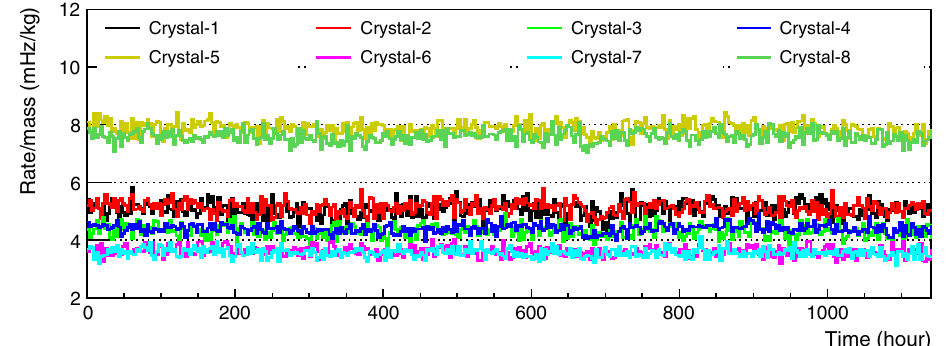
Fig. 15 Crystal trigger rates versus time (in h) for the first physics run (48 days). All of the crystals show stable behavior throughout this running period and the rest of data-taking